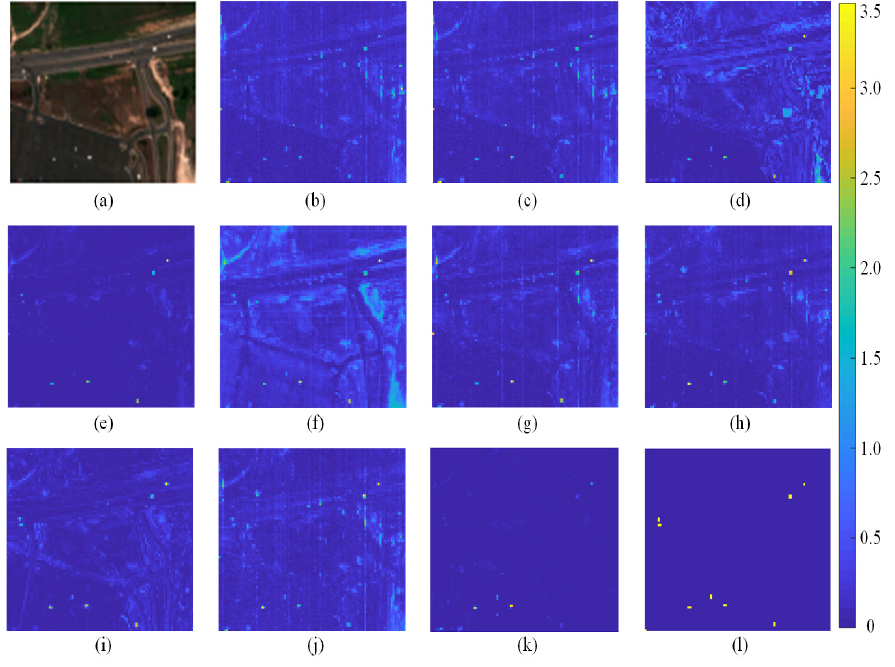
Figure 9. Detection results on the HYDICE dataset: ( a ) Pseudo-color image; ( b ) RX; ( c ) RX-DWT; ( d ) RX-Kernel; ( e ) RPCA; ( f ) LSMAD; ( g ) LRASR; ( h ) FrFE; ( i ) GTVLRR; ( j ) FEBPAD; ( k ) proposed method; ( l ) ground